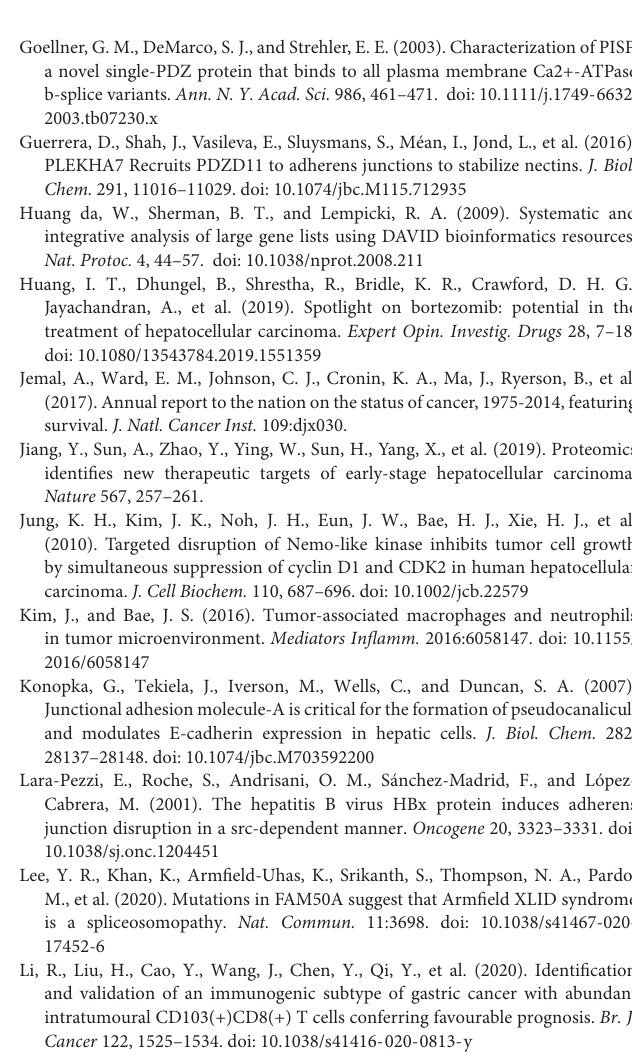
Supplementary Figure 1 | Protein-protein interaction (PPI) network of CDK5 Kinase-target networks (STRING).